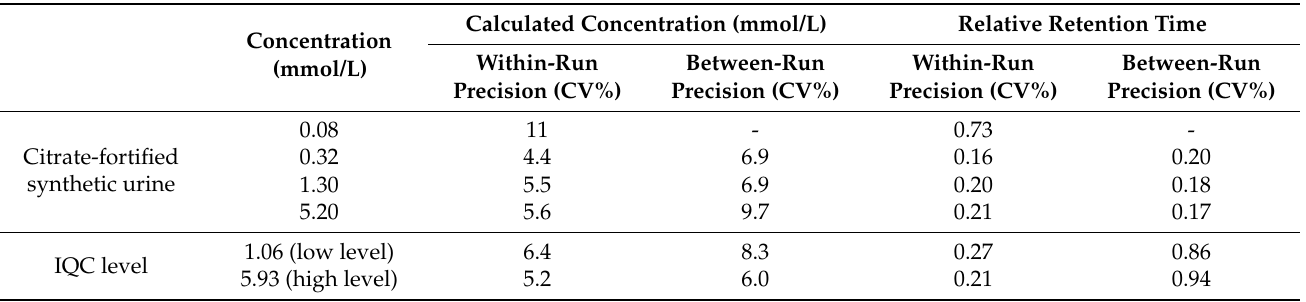
Table 3. Precision data of n.10 repeated assays, either in the series or in different days, of citrate- fortified synthetic urines and internal quality controls (low and high levels).